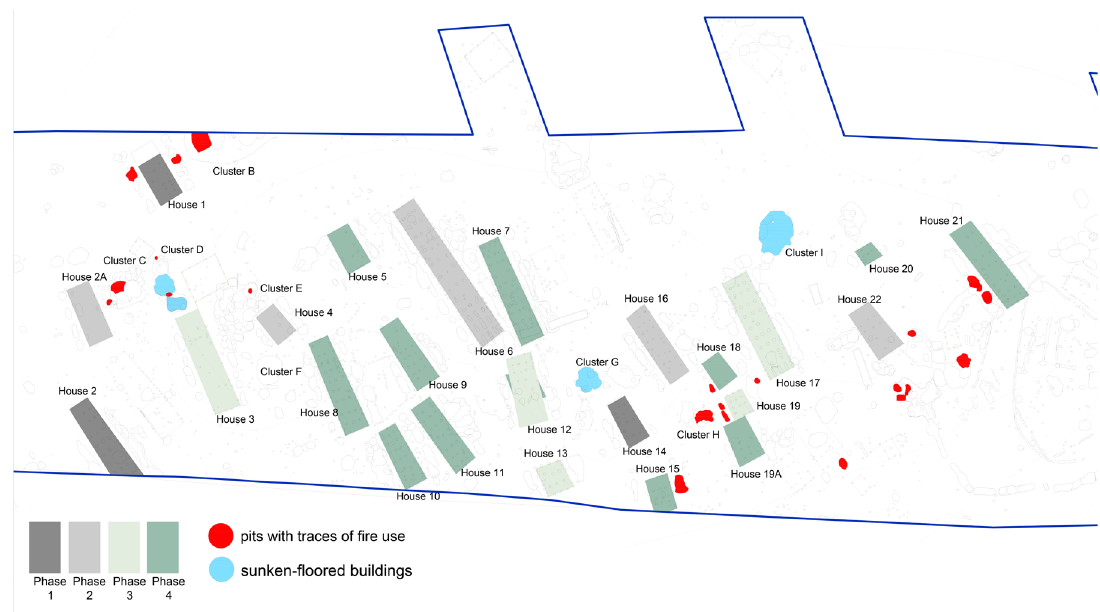
Figure 3: Plan of Targowisko site